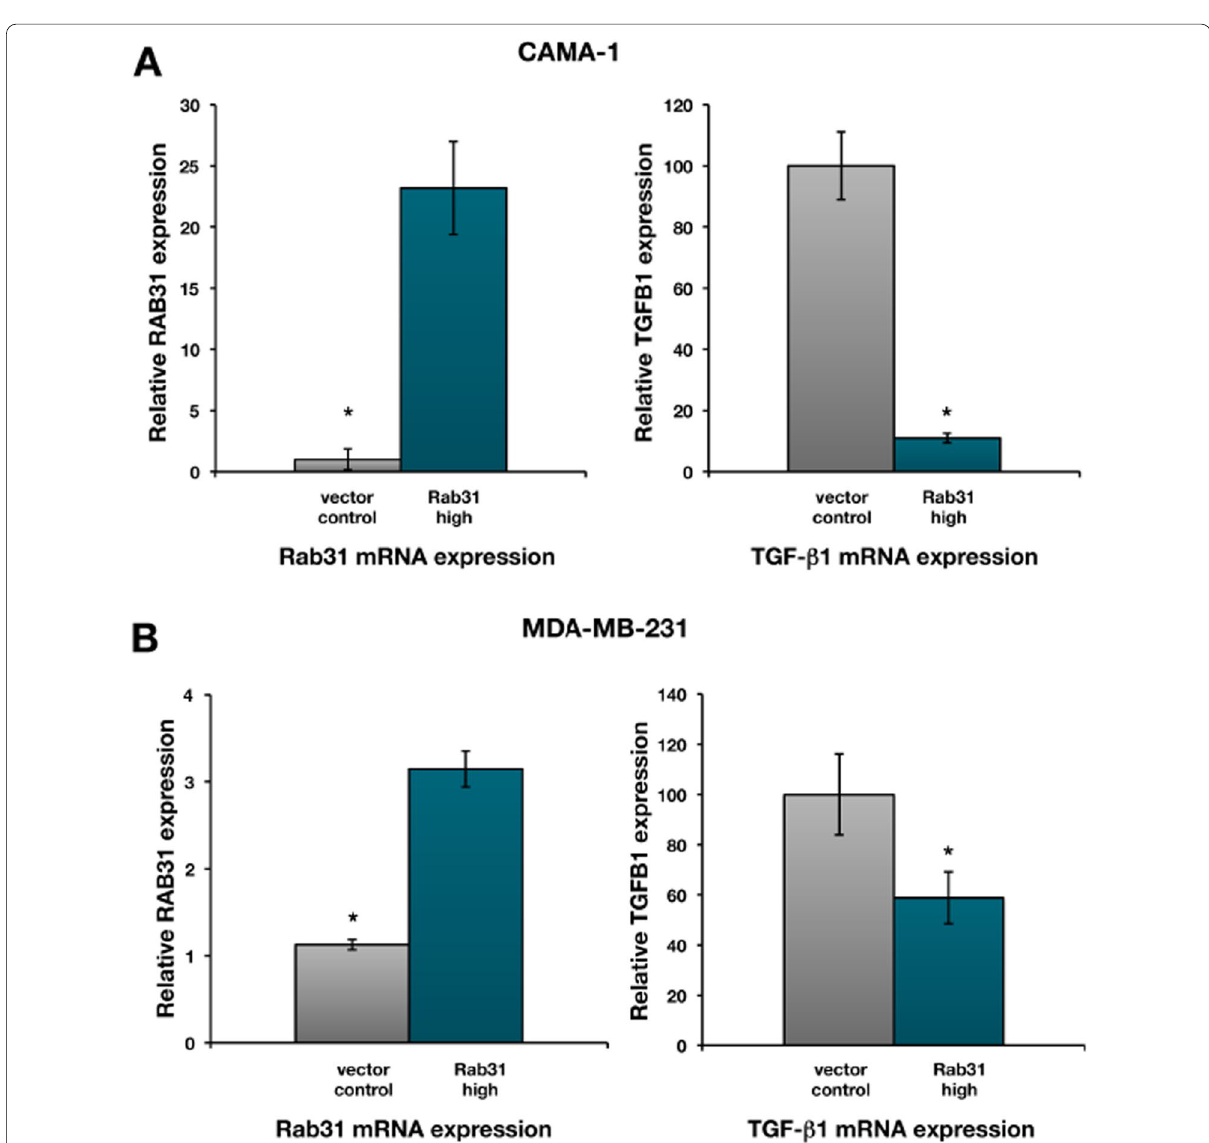
Fig. 3 Rab31 and TGF-ß1 mRNA expression in Rab31 overexpressing and vector control cells. Relative Rab31 and TGF-ß1 mRNA expression levels, normalized to the HPRT1 mRNA expression levels, in CAMA-1 ( A ) and MDA-MB-231 ( B ) breast cancer cells, respectively. Three experiments were performed in triplicates each. Statistically significant differences (p < 0.05) are indicated by an